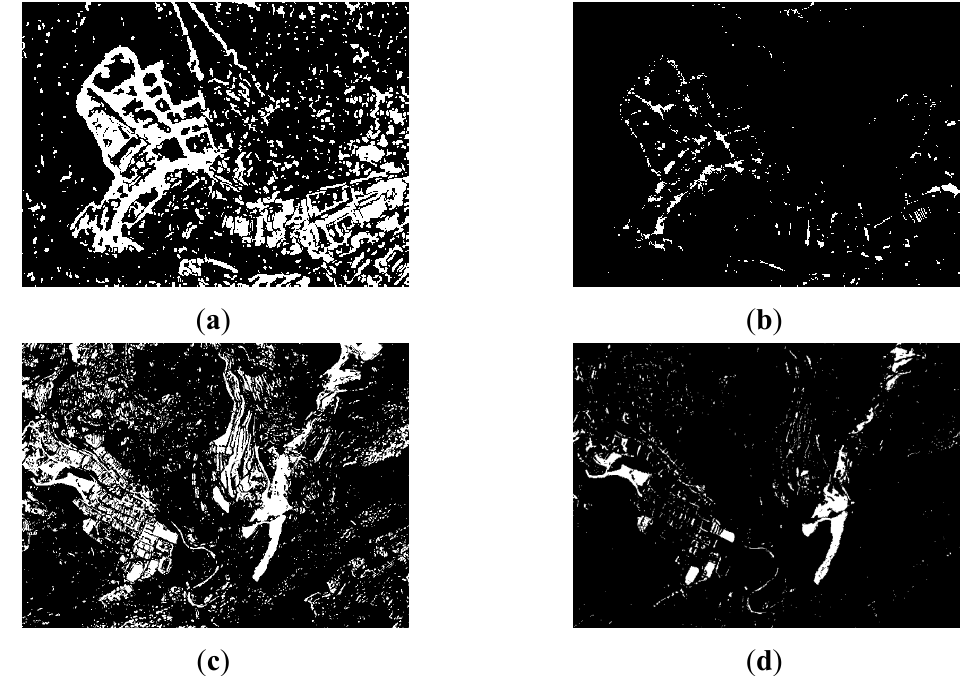
Figure 11. Level 3. Change detection documents ( λ method–area 1; ( b ) Multiplicative method–area 1; ( c ) Summative method-area 2; ( d ) Multiplicative method-area